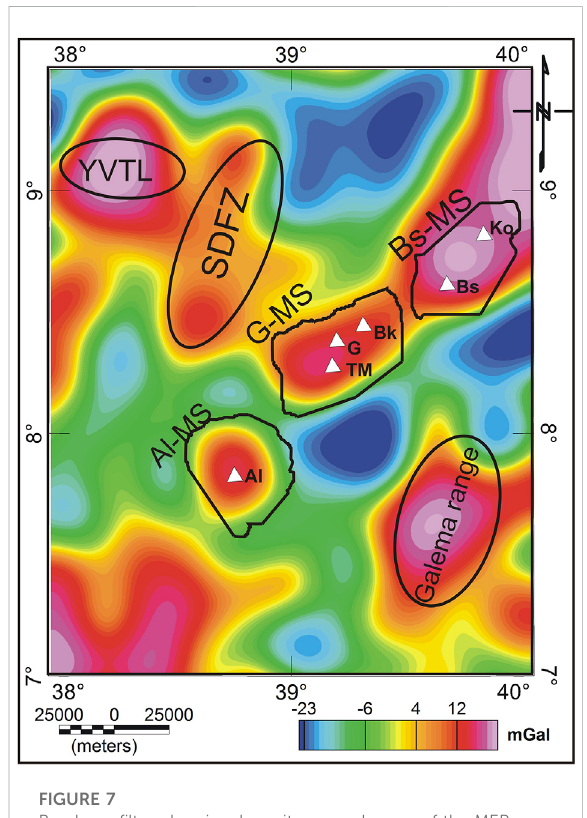
FIGURE 7 Bandpass fi ltered regional gravity anomaly map of the MER where wavelengths between 40 and 200 km are passed. The elliptical-shaped solid black lines are the off-rift volcanic regions (YVTZ, SDFZ, and Galema range). Labels: Al-MS, G-MS, and Bs-MS represent Aluto, Gedemsa, and Boseti magmatic segments